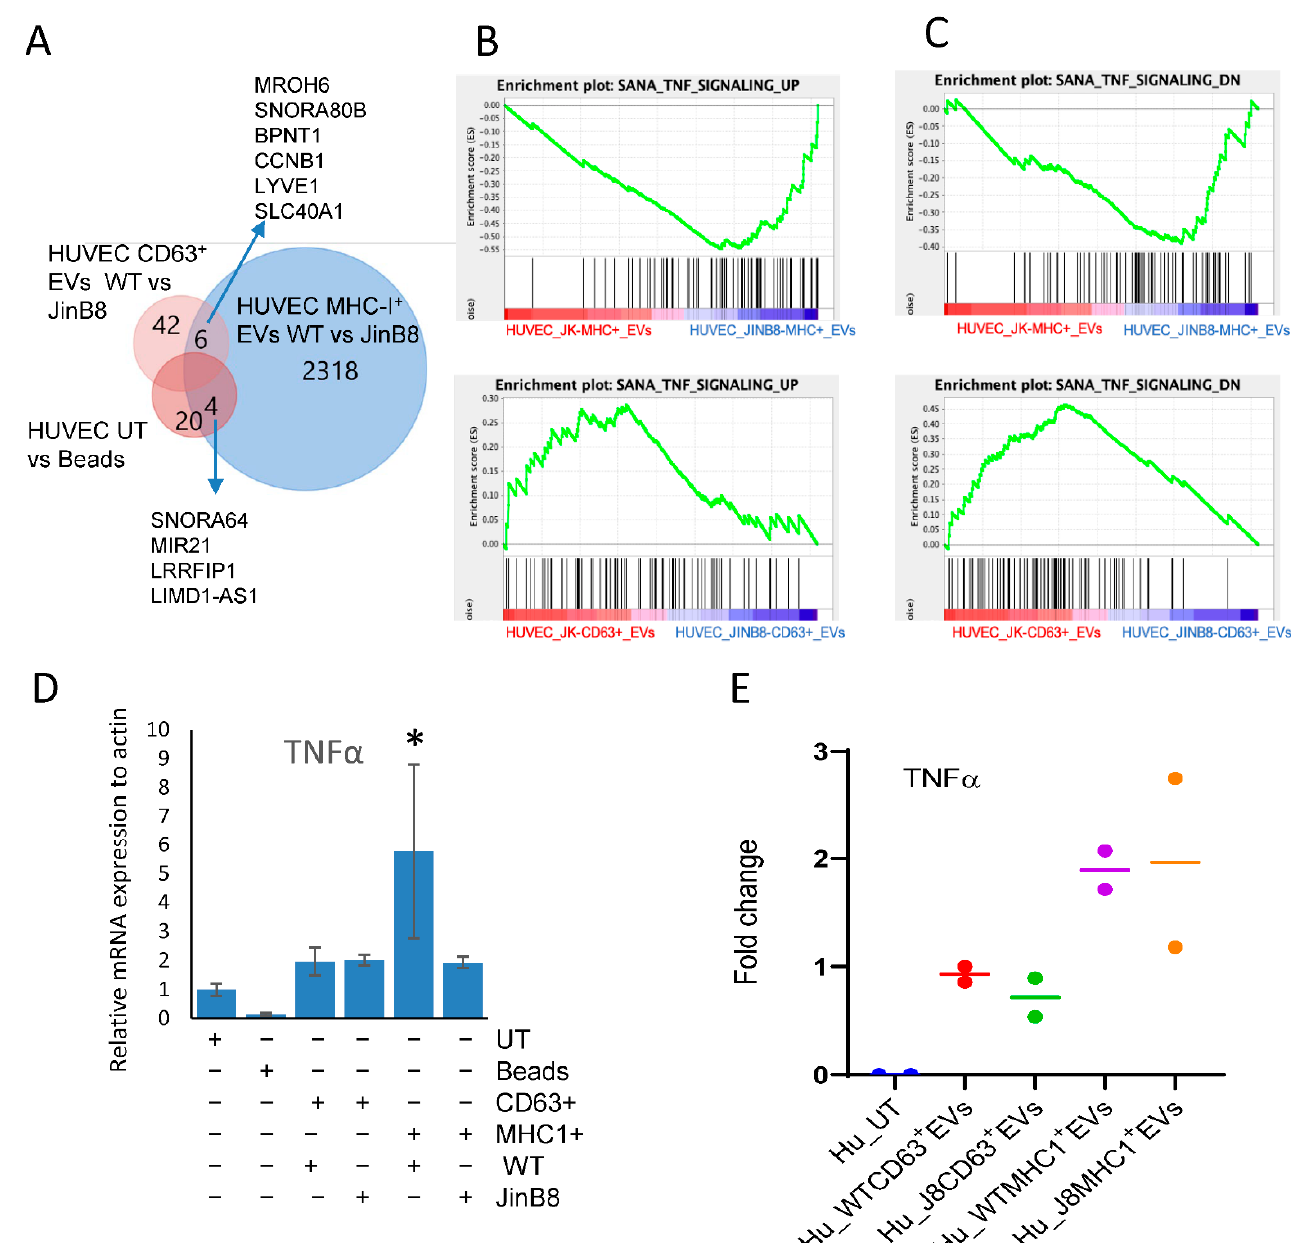
Figure 5. Immunocaptured CD63 + and MHC-I + EVs as in Figure 3A were co-cultured with HUVEC for 3 days, and differential mRNA expression was evaluated using microarray analysis. ( A ) Venn diagram showing comparative analysis of CD47-dependent transcripts ( p < 0.05) in HUVEC treated with beads alone or treated with CD63 + or MHC-I + EVs from WT Jurkat or JinB8 T cells. ( B , C ) Geneset enrichment analysis plots showing enrichment of a TNF signaling signature in HUVEC treated with CD63 + EVs from WT Jurkat vs. JinB8 T cells ( B ) or MHC-I + EVs from WT Jurkat vs. JinB8 T cells ( C ). ( D ) TNF α mRNA expression was validated via real-time PCR with ß-actin as control (1 biological replicate). ( E ) The increase in fold change of secreted TNF α in conditioned medium from HUVEC treated with the indicated EVs for 3 days. Secreted TNF α was undetectable from supernatant of untreated HUVEC cells, but control bead-treated sample had background values. Therefore, results are presented as fold change with respect to background value ( n = 2). Supplemental Data files related with Figure 5; /Data/s3A, /Data/s3B, /Data/s2C. * p < 0.05. Treatment of HUVEC with MHC ‐ I + EVs or CD63 + EVs from WT Jurkat and JinB8 T cells for 3 days along with bead control demonstrated that TNF α mRNA expression was increased in WT Jurkat MHC ‐ I + EVs only as compared to all other treatments (Figure 5D). Similar results were found for secreted TNF α , which increased in HUVEC treated with